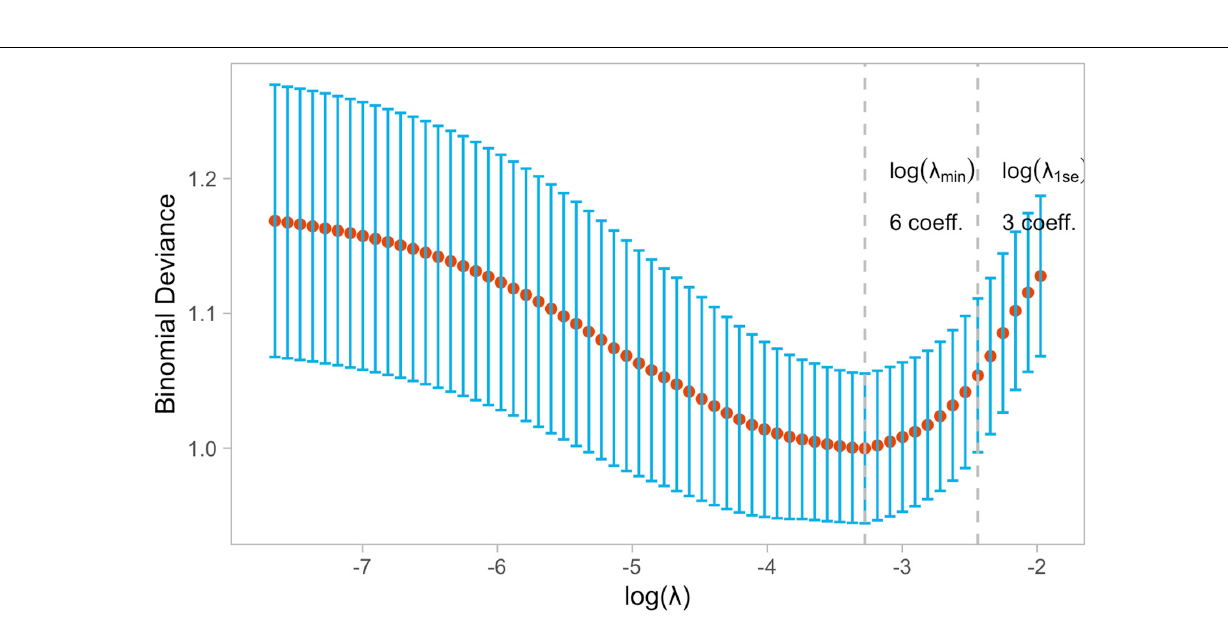
Frontiers in Cardiovascular Medicine |